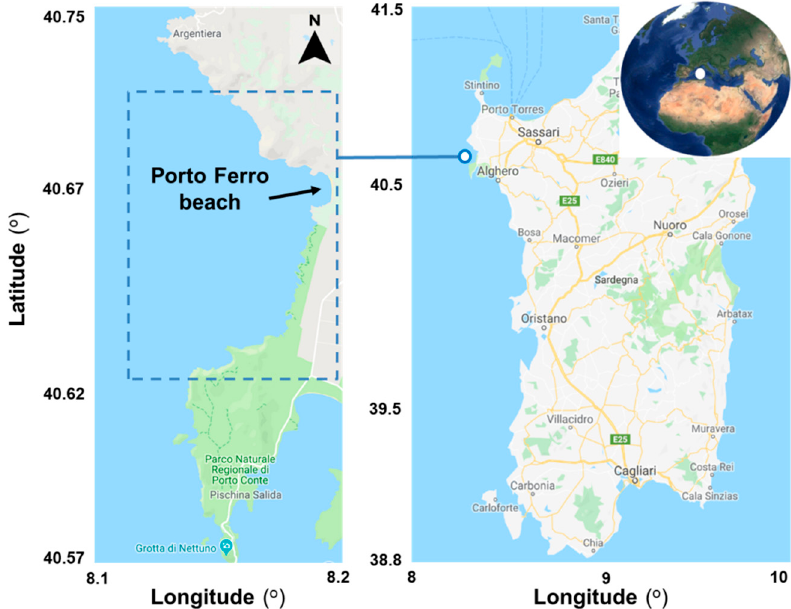
Figure 1. Sardinia Island and the geographical location of the target area. Figure processed from Google Earth